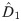
Distance contrast D^1 between the 10 × 100 two-dimensional lattice graph and the the degree matched configuration model (null model).